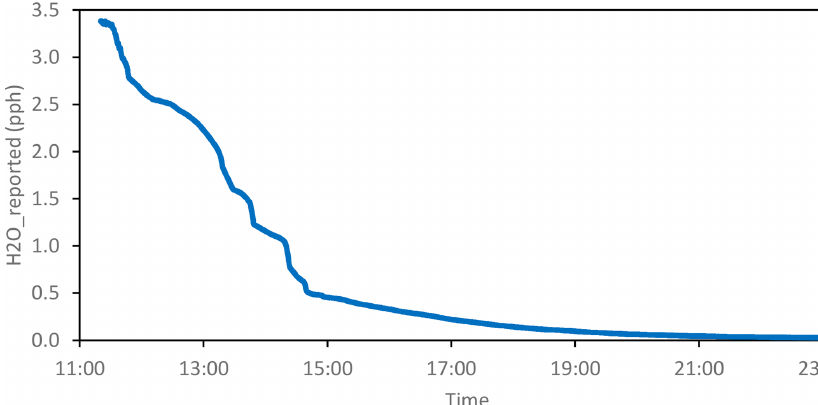
Figure 9. Evolution in time of the h2o_reported (pph) determined by the CRDS.